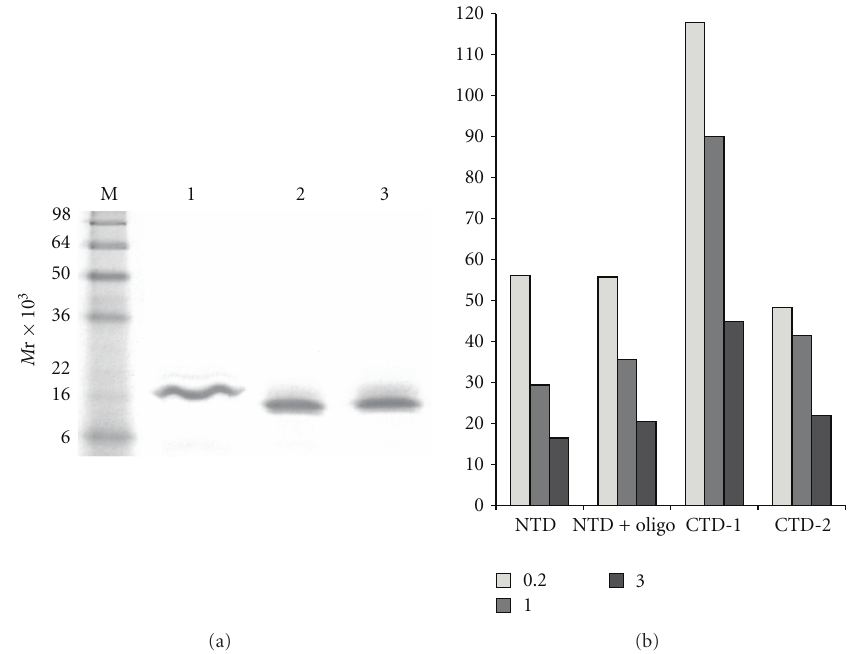
Figure 4: (a) SDS-PAGE analysis of 2.5 μ g purified HvRPA3-NTD, HvRPA3-CTD-1, and HvRPA3-CTD-2. The 6xHis-tagged constructs have predicted MWs of 18 . 9 × 10 3 (HvRPA3-NTD) and 17 . 6 × 10 3 (HvRPA3-CTD). (b) Predicted MWs ( y axis, × 10 3 ) from size exclusion chromatography analysis of HvRPA3-NTD, HvRPA3-CTD-1, and HvRPA3-CTD-2 in 0.2, 1, and 3M KCl (light, mid, and dark grey, resp.). HvRPA3-NTD in complex with 18mer ssDNA is also